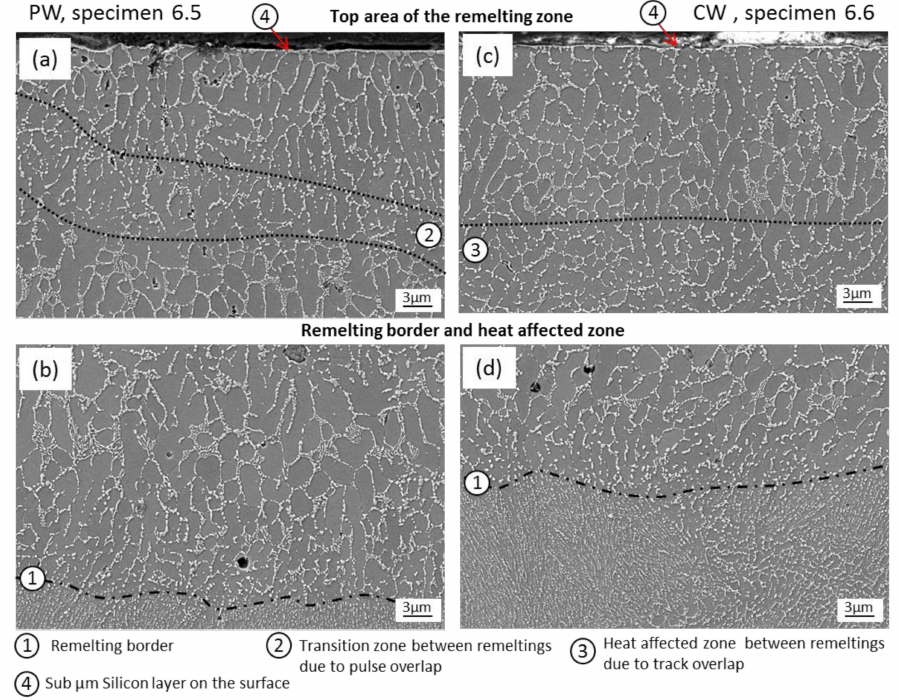
Figure 12. SE-SEM images at 2500-fold magnification of the surface near top area and border of the remelting zone polished with pulsed laser radiation (PW) ( a , b ) and continuous laser radiation (CW) ( c , d